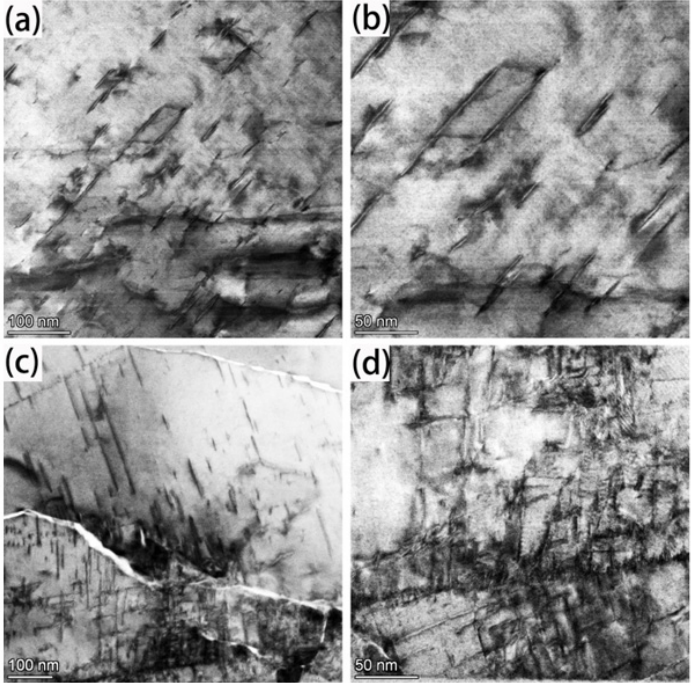
Figure 5. Bright-field TEM microstructure images of the 0.02PSmN-0.68PMN-0.30PT single crystal under ( a , b ) alternating current polarization (ACP); ( c , d ) direct current polarization (DCP).